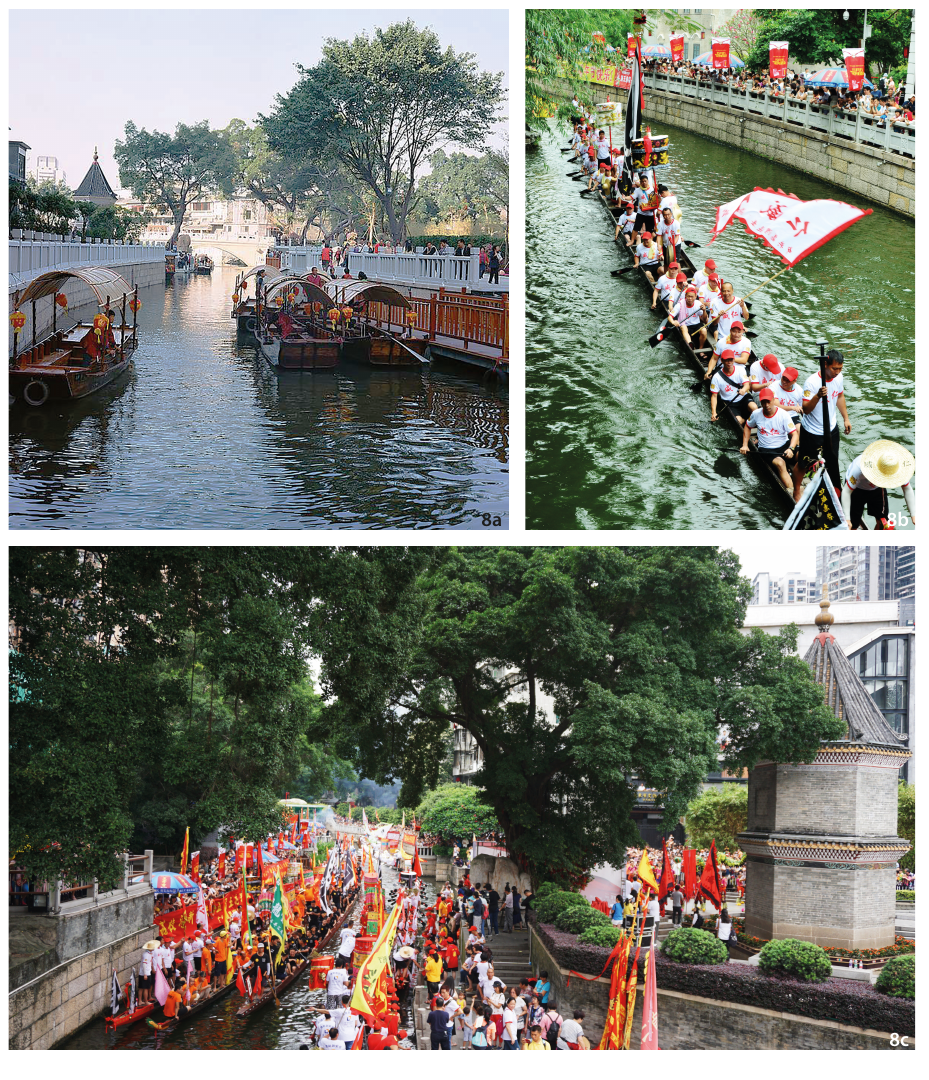
Figure 8a Activities on Litchi Bay Canal now, sightseeing boats docked in the quay (Source: Yongjian Guo). Figure 8b Activities on Litchi Bay Canal now, the 40-m long dragon boat on Litchi Bay Canal (Source: Ke Chen). Figure 8c Dragon boat racing during the Dragon Boat Festival around the Pagoda Plaza (Source: Jun